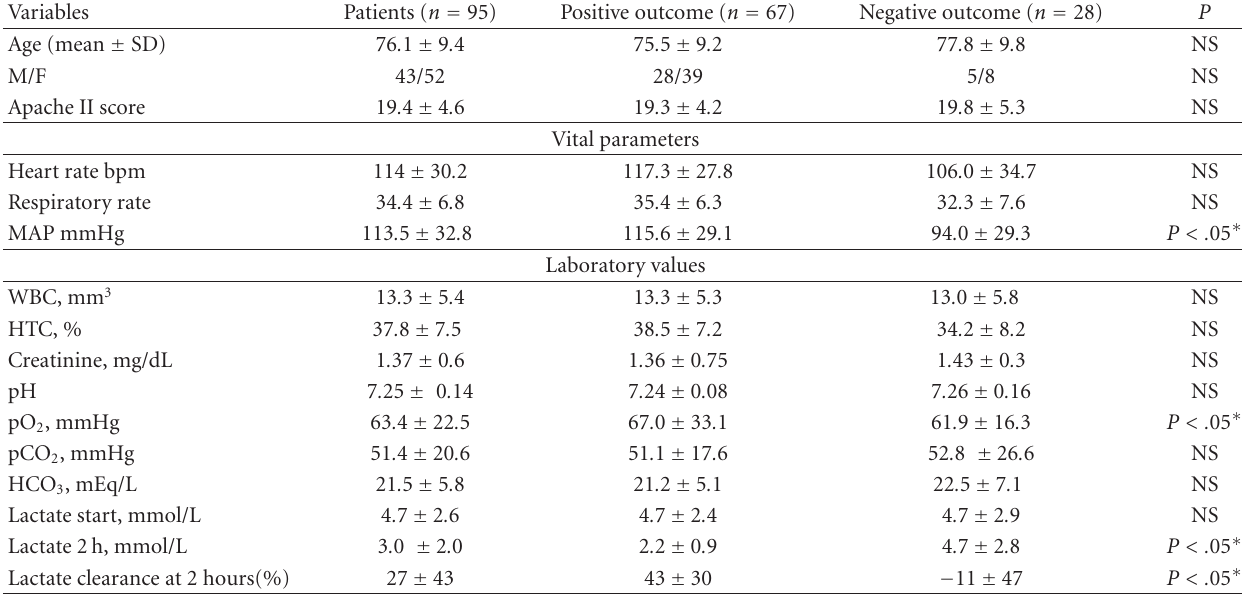
Table 1: Patient characteristics.